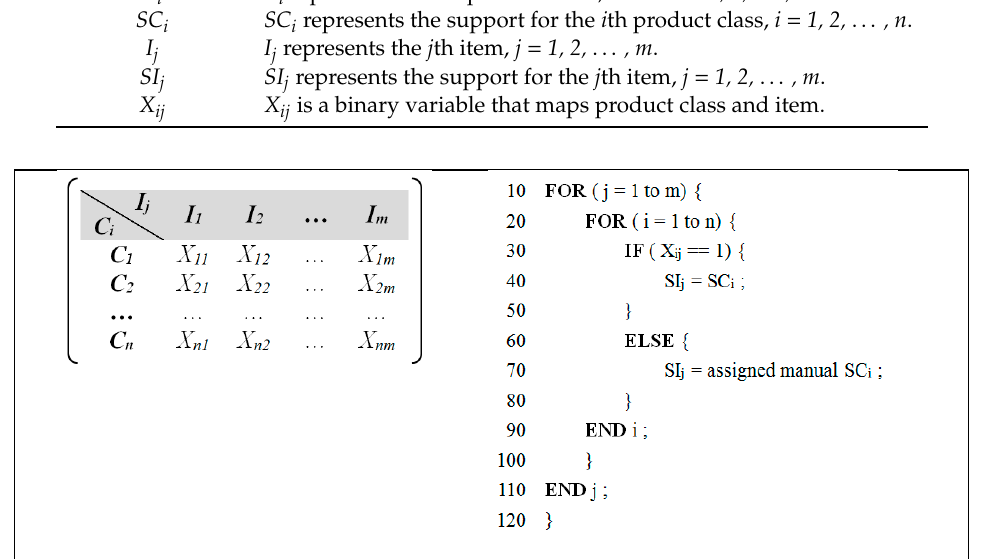
Figure 2. Pseudo code of “classification of items (COI)”.